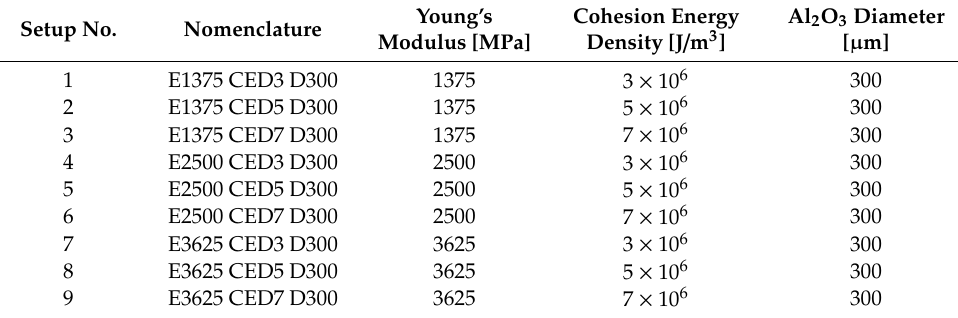
Table 4. Summary of interaction parameters used in DEM simulations.